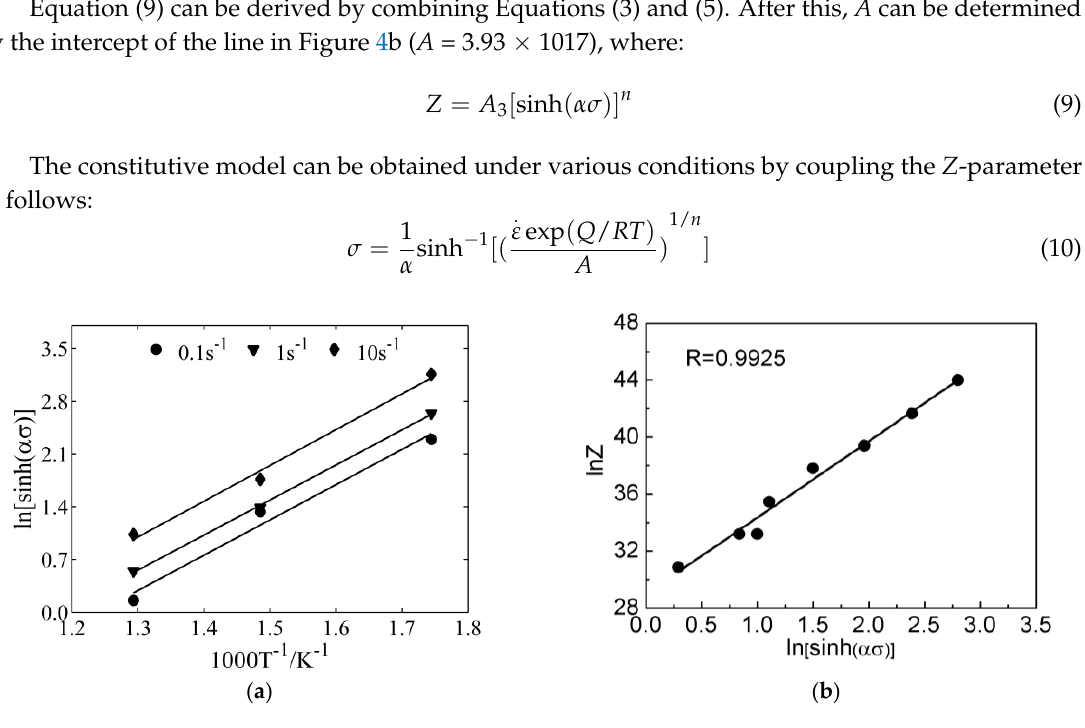
ln[sinh( )]  Figure 4. The relations between ( a ) and 1000 T −1 ; and ( b ) ln Z and Figure 4. The relations between ( a ) ln [ sinh ( ασ )] and 1000 T − 1 ; and ( b ) ln Z and ln [ sinh ( ασ )] ln[sinh( )]  .